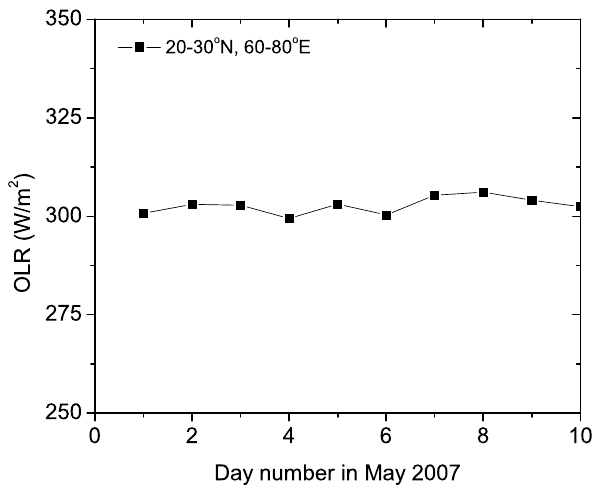
Fig. 6. The NCEP-OLR data averaged for a grid covering latitudes: 20–30 ◦ N and longitudes: 60–80 ◦ E exhibiting subdued convective activity over the